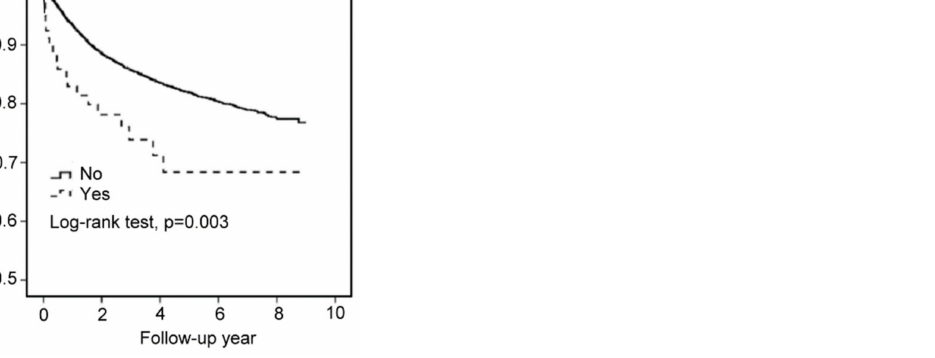
Figure 7. Using haloperidol reduces the survival outcome of EC patients . Kaplan–Meier survival curves for EC patients with or without